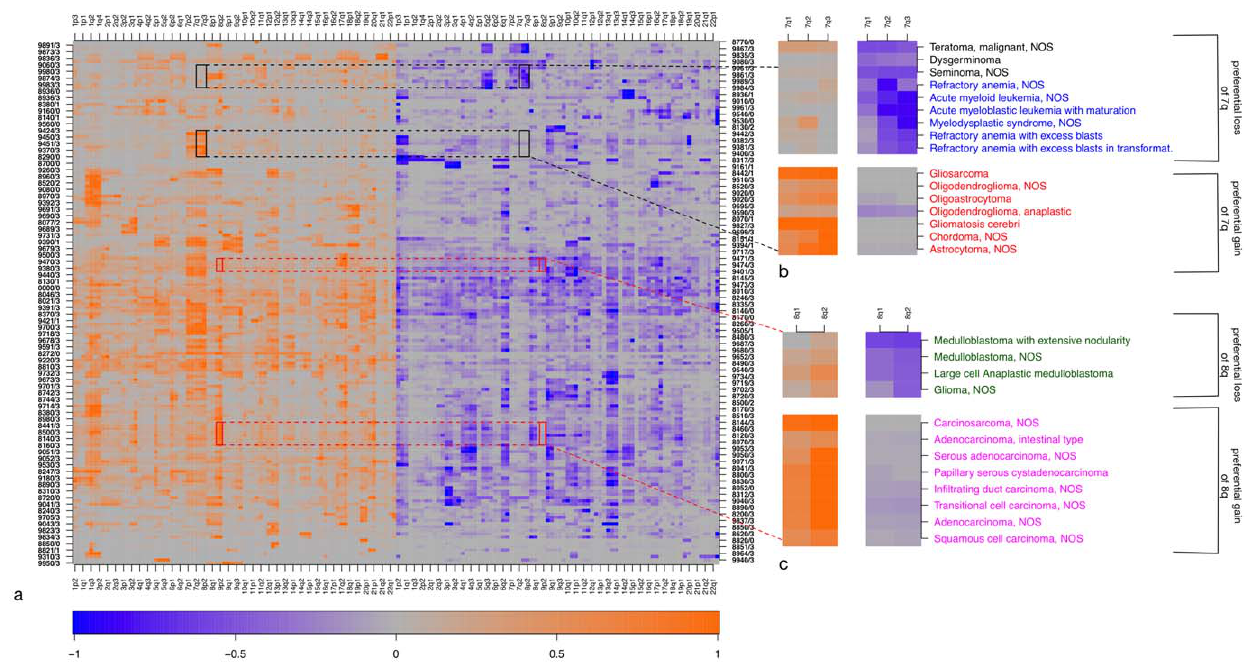
Figure 3. Examples for non-neutral CNA regions. a) Heatmap of CNA profiles on genomic regions (same clustering as in Figure 2). Genomic locations are represented with orange color when considering duplications/gains, and in blue when considering deletions/losses. Color intensity shows relative CNA frequencies; the most-affected region in each row is arbitrarily set the to brightest color (1.0) for display purposes. b) Small regions (black rectangles on the heatmap) are zoomed in to show how non-neutral CNAs can differentiate between cancer types. The example shows that 7q is preferentially gained in brain tumors (red labels) whereas it is preferentially lost in germ cell (black labels), myeloid and myeloproliferative cancer types (blue labels). c) Small regions (red rectangles on the heatmap) are zoomed in to show how 8q is preferentially lost in medullublastomas (green labels) and is preferentially gained in epithelial tumors (pink labels). Some chromosomes consist entirely of non-neutral regions (such as chromosomes 18 and 7). Note that the spatial resolution of the CNA data on the chromosome is limited (roughly corresponding to cytogenetic band resolution).